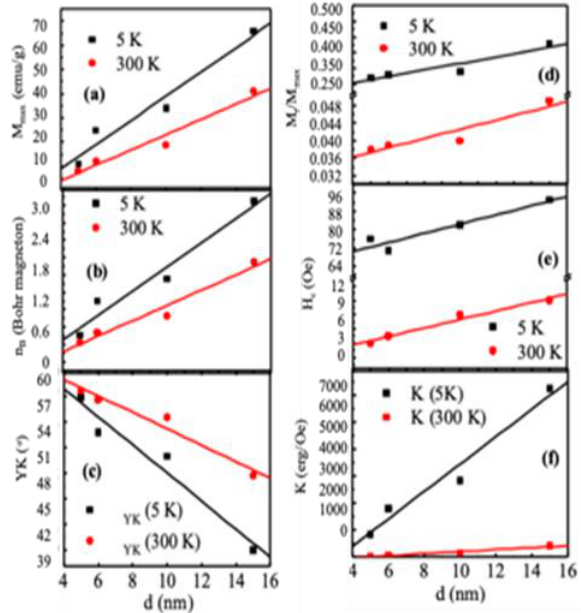
Figure 5. ( a ) Maximum magnetization ( b ) Bohr magneton, ( c ) Canting angles, ( d ) squareness ratio, ( e ) coercivity, and ( f ) anisotropy with size variations of MnFe 2 O 4 nanoparticles.